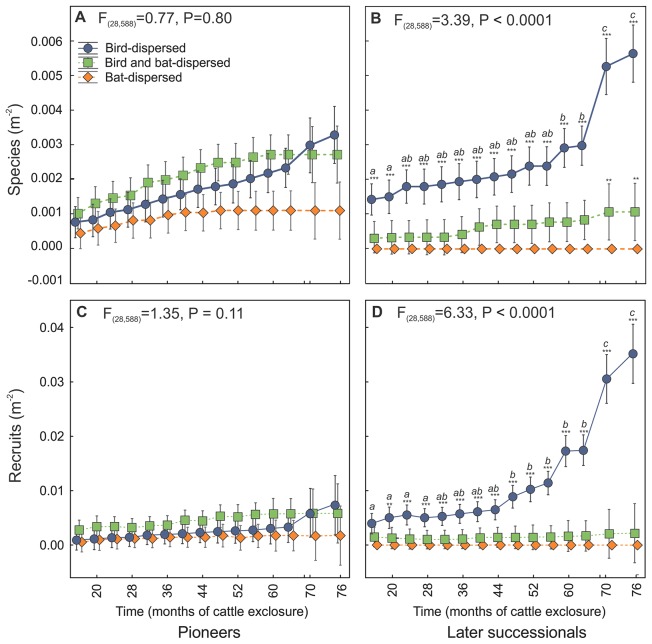
Changes in density of recruited species and individuals by dispersal group over time.Shown are (A) pioneer species, (B) later-successional species, (C) pioneer individuals, (D) later-successional individuals. Blue circles indicate primarily bird-dispersed, green squares both bird- and bat-dispersed, and rust diamonds primarily bat-dispersed species. Asterisks indicate differences between dispersal categories in the same time period. ANOVA statistics indicate disperser category by time interactions. Letters show differences for bird-dispersed later-successional trees from one time period to the next using conservative Bonferroni post-hoc tests (P≤0.05). Shown are means and 95% confidence intervals.